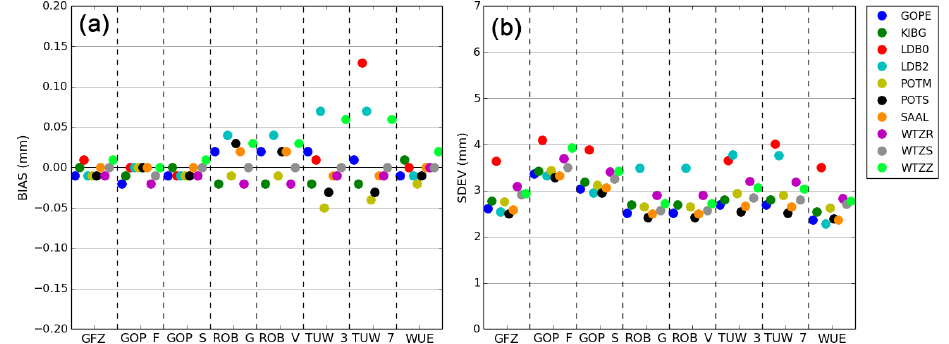
Figure 6. Comparison of individual GNSS STD solutions without residuals (nonRES) and with clean residuals (clnRES); statistics are projected in the zenith direction: bias (a) and standard deviation (b)